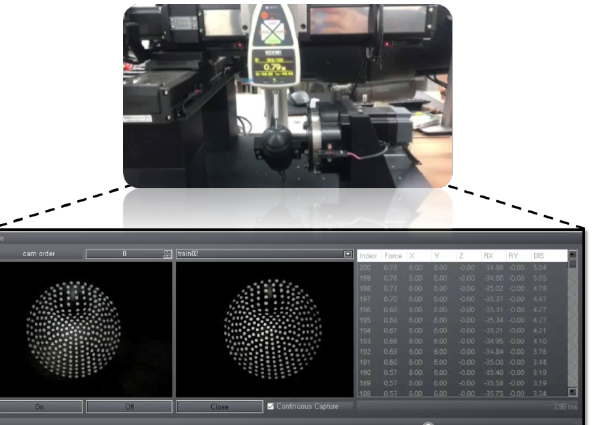
Figure 2. Problem statement of vision-based tactile sensor mechanism for the estimation of contact location and force distribution using deep learning: Data acquisition and training and inference